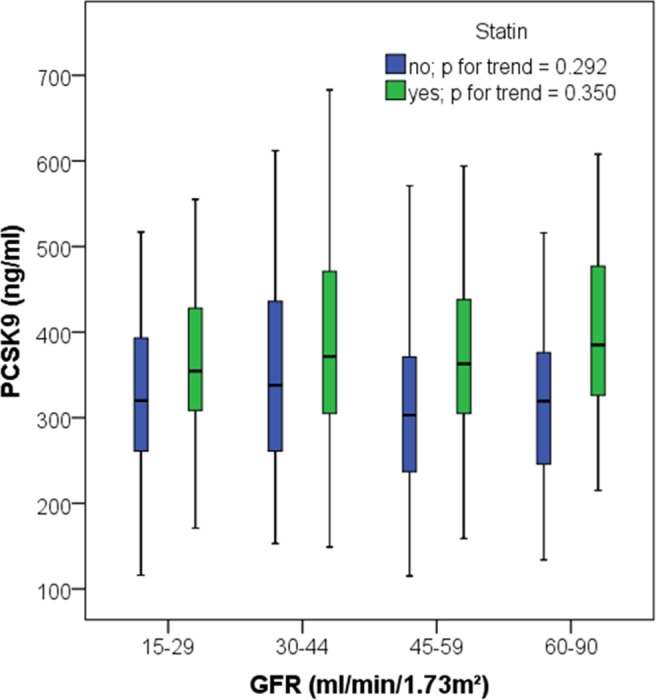
Association of PCSK9 with strata of GFR in patients taking statins and patients not on statin medication; Jonckheere Terpstra test for comparison among statin users, respectively statin non-users, across GFR strata.